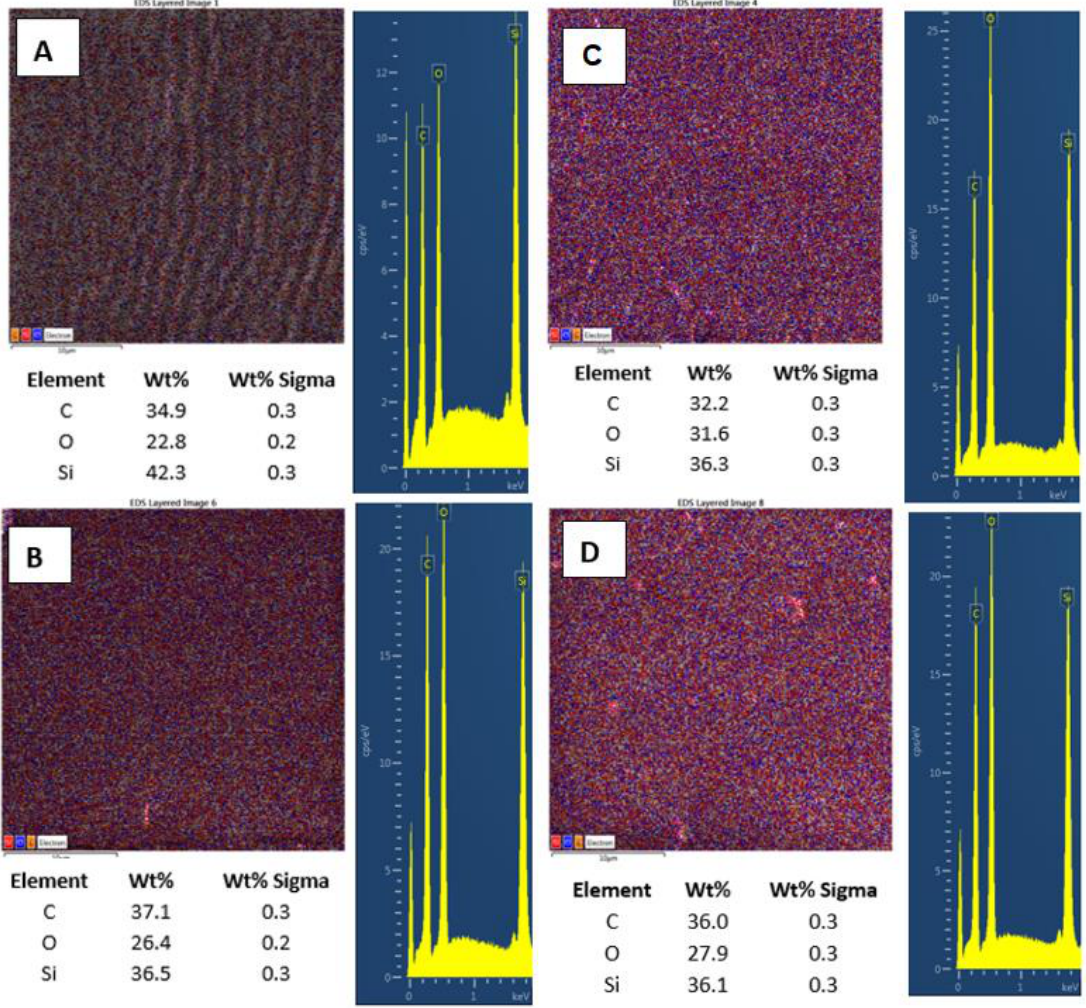
Figure 7. EDS/EDX analysis of PDMS ( A ), PDMS/C (carbon composite 2 wt.%) ( B ), PDMS laser- treated with 500 mJ and 6000 pulses, ( C ) and PDMS/C laser-treated with 500 mJ and 6000 pulses ( D ). Elemental mapping, weight concentration in %, and relevant EDS/EDX spectra are presented.